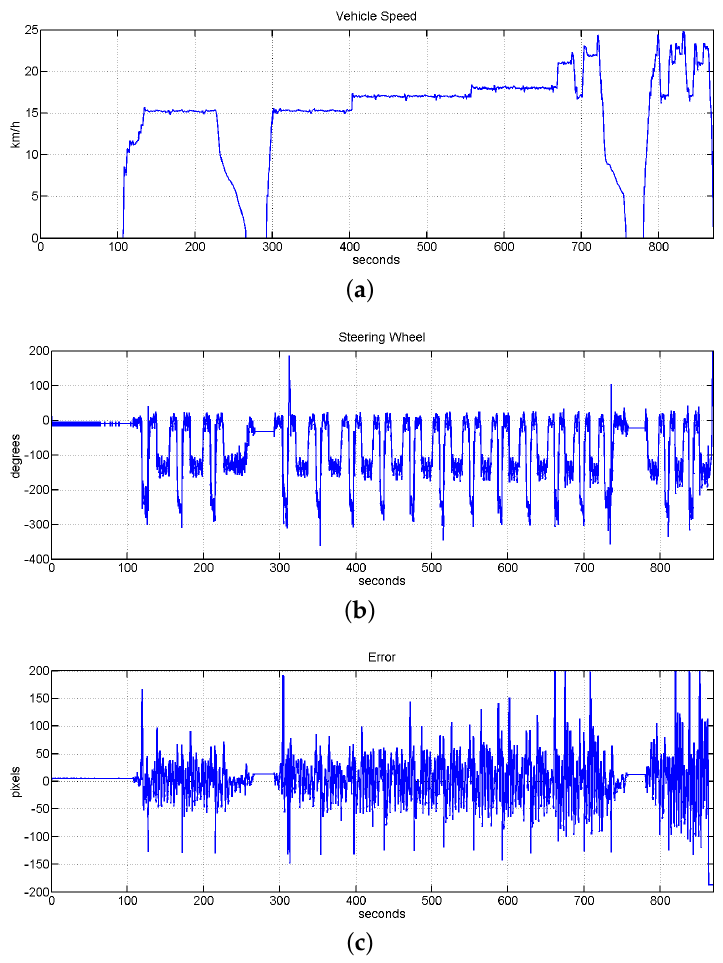
Figure 24. Evolution of the system with the speed assistance and the autonomous driving system working together and checking speed limits. It is also shown the response of the system to accomplish visual marks based stops. ( a ) Vehicle speed evolution; ( b ) evolution of the steering wheel; ( c ) evolution of the error measured in pixels, the value of RMSE for this test is equal to 5.5535 cm. During the experiments presented on this and the previous blocks the comfort of the vehicle respect to the speed and the behavior of the lateral control system were tested at different speeds. The evaluation of these tests was done based in the feedback of some participants and the examination of the data obtained. Finally the speed limits of each section were set based on the extracted